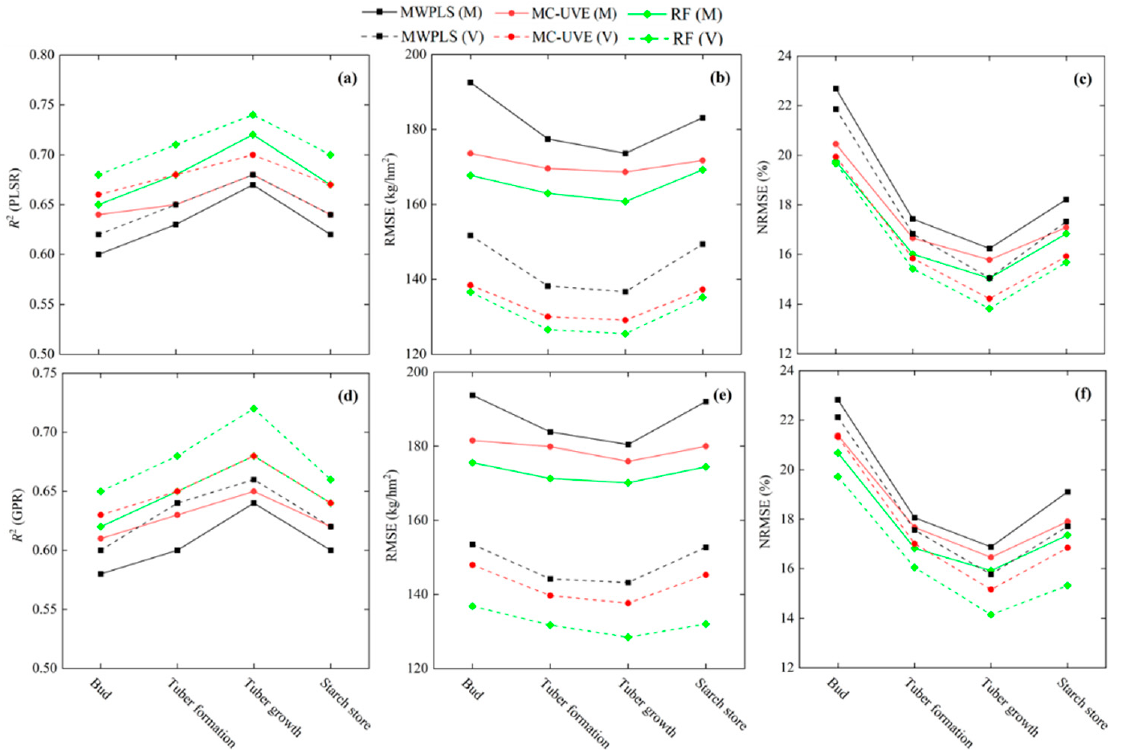
Figure 13. Accuracy of estimating AGB based on the feature variables screened from composite variables by MWPLS, MC-UVE and RF. ( a – c ) The R 2 , RMSE (kg/hm 2 ) and NRMSE (%) of AGB was estimated using the PLSR method. ( d – f ) The R 2 , RMSE (kg/hm 2 ) and NRMSE (%) of AGB was estimated using the GPR method.